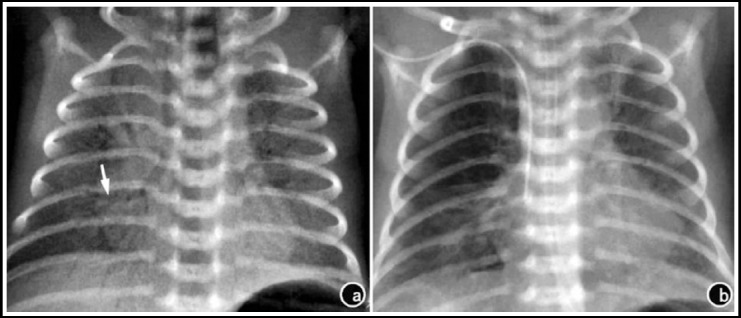
Pulmonary X-ray results of neonate No. 1 before and after treatment. a) 3 h after birth, before treatment; b) 30 h after PS treatment.